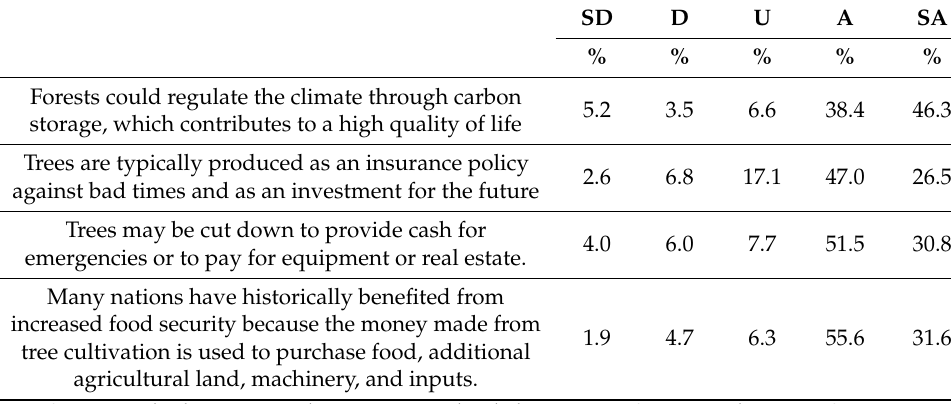
Table 6. Results on social and economic development related to forests.